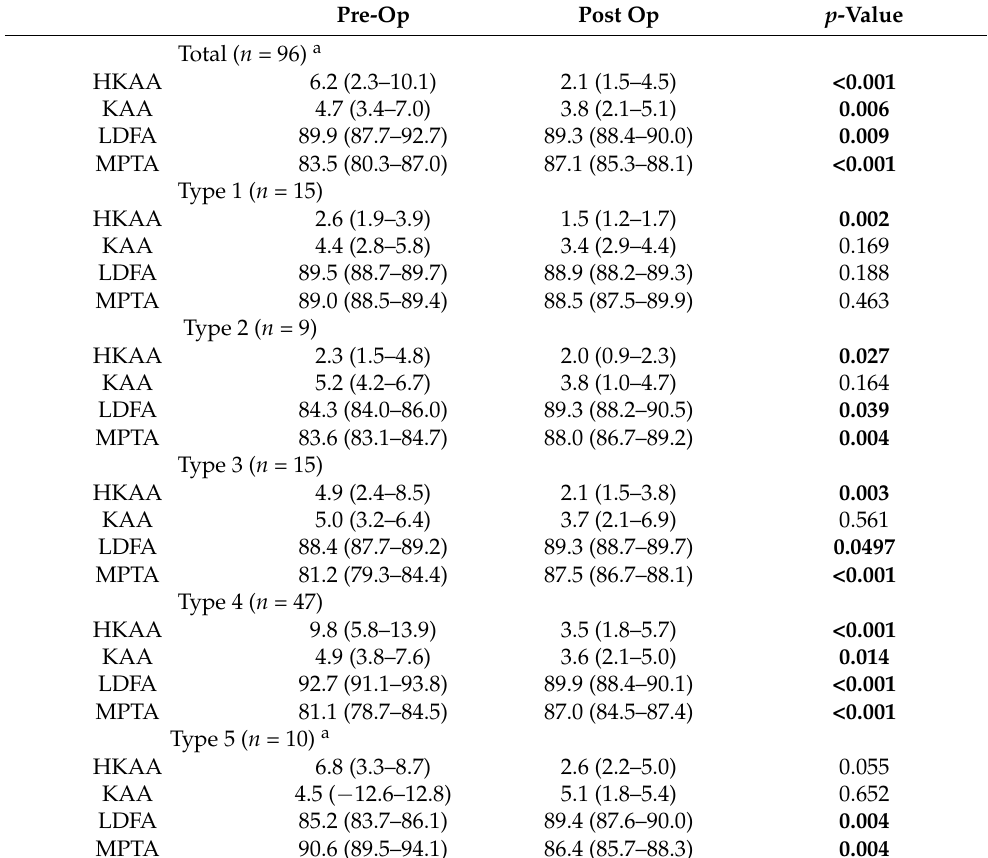
Table 2. Correction of irKA in coronal alignment in different phenotypes.